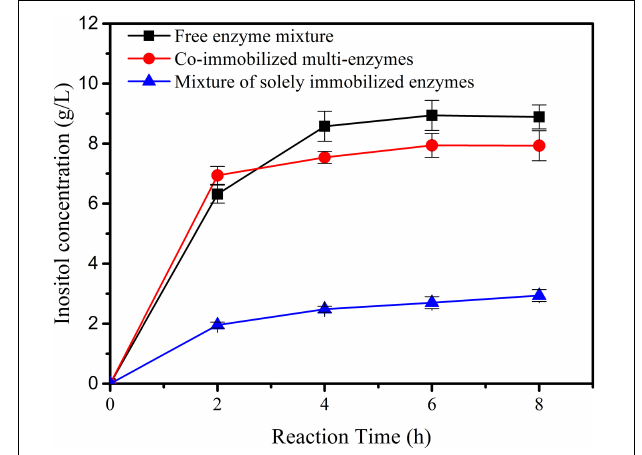
FIGURE 4 | Recycling stability of free and immobilized IPS.